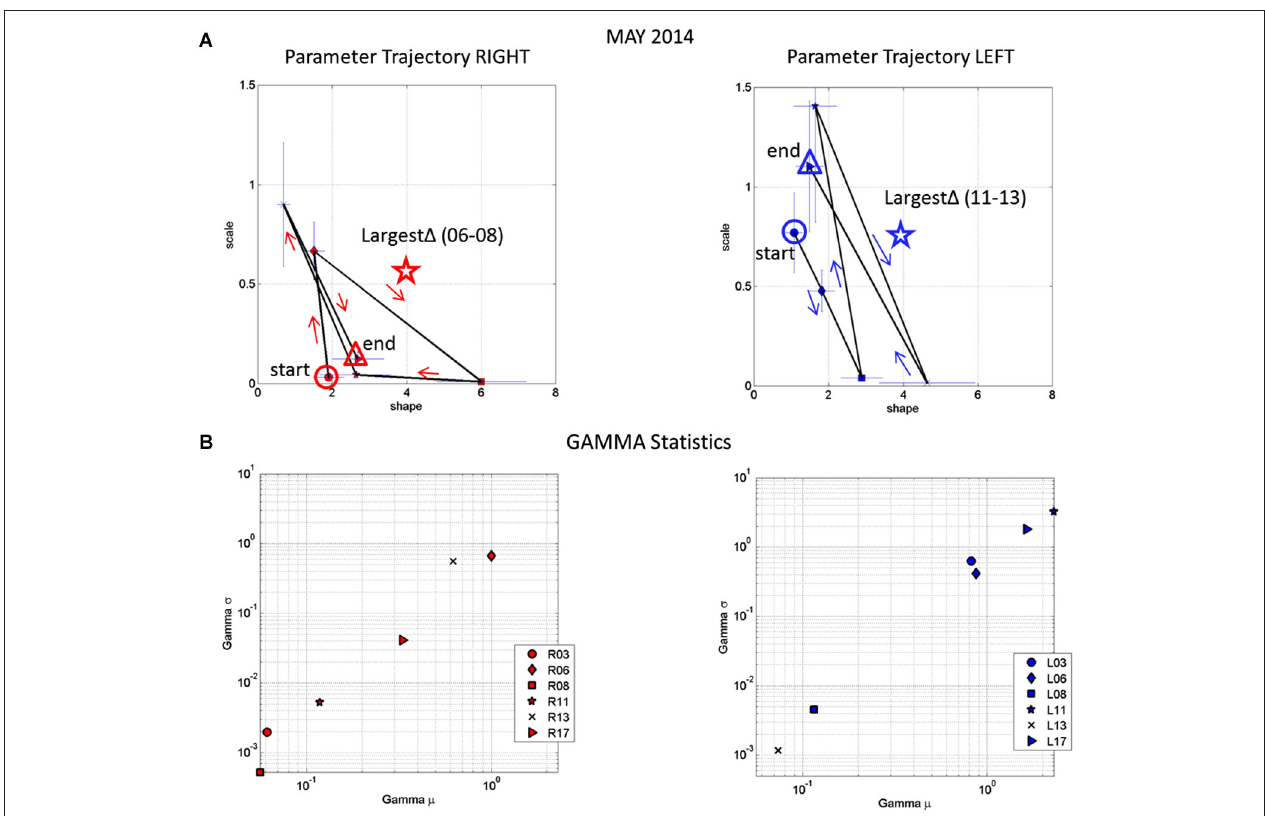
Gaussian-like range of the Gamma plane) and drop in scale value (decrease in the noise-to-signal ratio). (B) Estimated mean and variance parameters of the Gamma probability distribution for each session (see legend with dates for right R and left L cases) with symbols corresponding as well to parameters in (A) . The log-log plot is used for better visualization. Notice that the values of the variance and the mean corresponding to the maximal shifts in stochastic parameters marked by stars in (A) are at the extreme locations of the Gamma-statistics